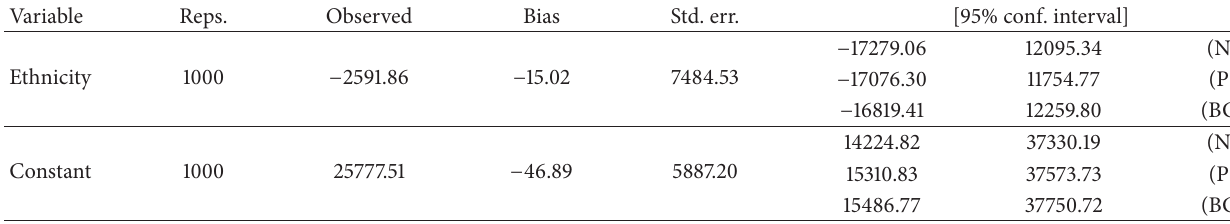
Table 3: Bootstrap regression of cost between ethnic groups.